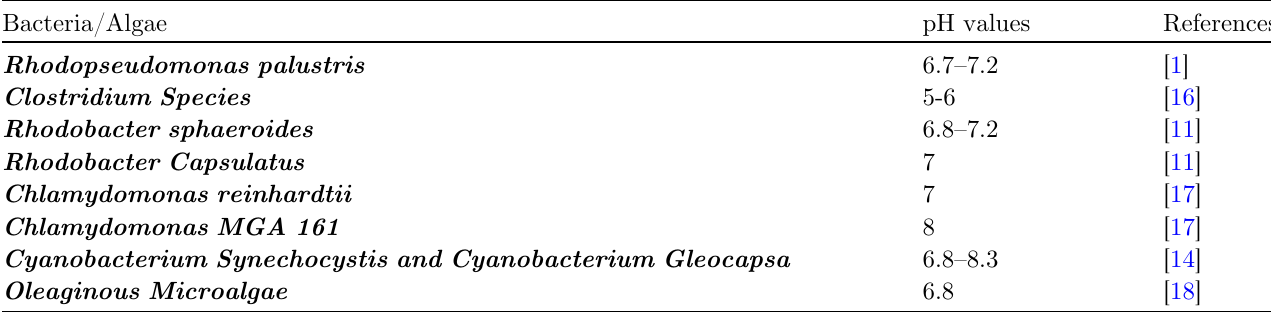
Table 6. Optimal pH values for speci fi c species of algae and bacteria. Bacteria/Algae